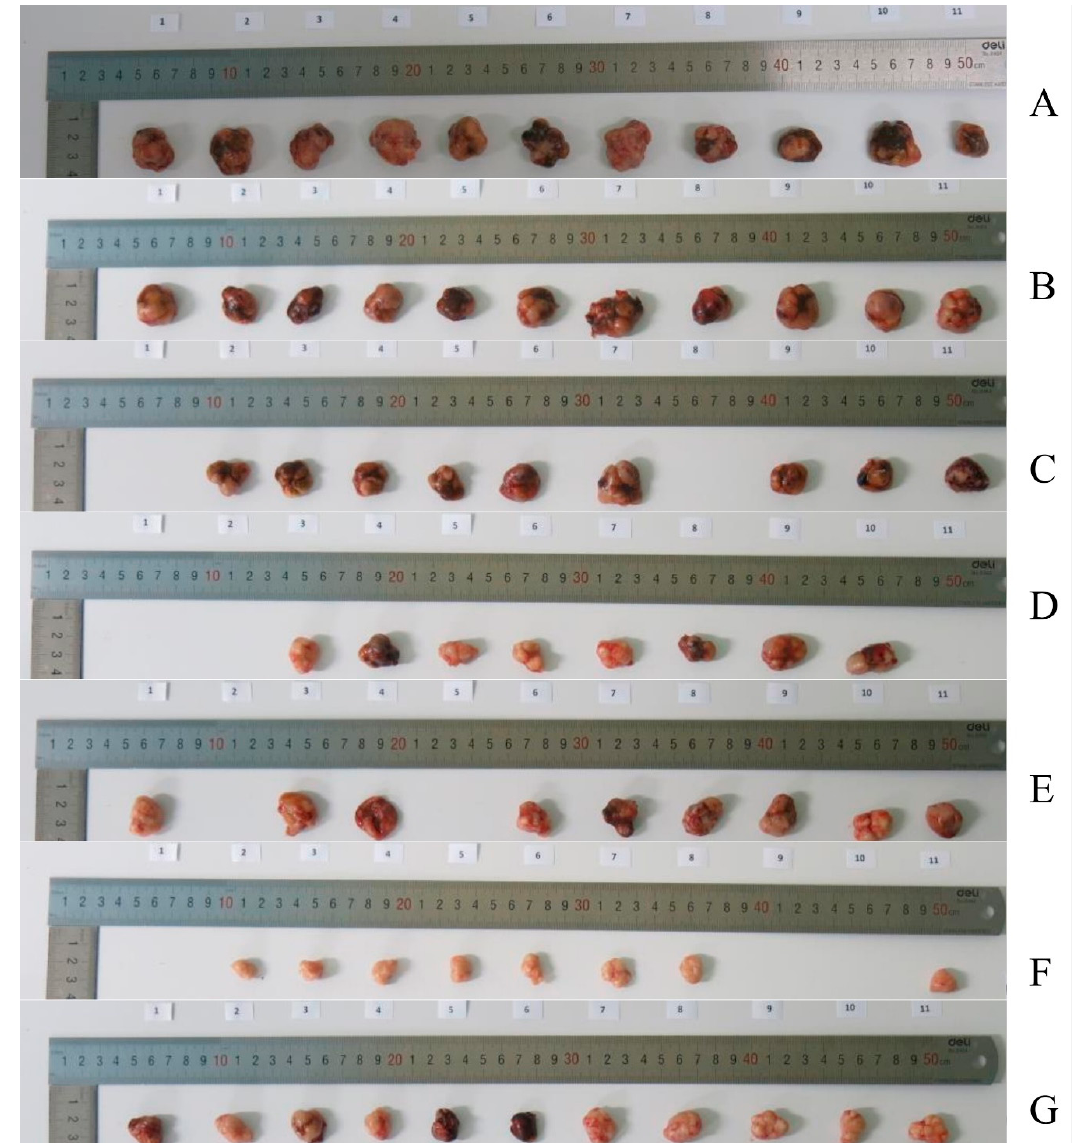
Figure 4. The tumor tissues figure with paclitaxel-resistant lung adenocarcinoma. A , 5% glucose; B , blank liposome; C , taxol injection 10 mg/kg; D , cabazitaxel injection 2.5 mg/kg; E , β -elemene liposome 25 mg/kg; F , cabazitaxel liposome 2.5 mg/kg; G , cabazitaxel- β -elemene complex liposome 0.625 mg/kg after the first 2.5 mg/kg.